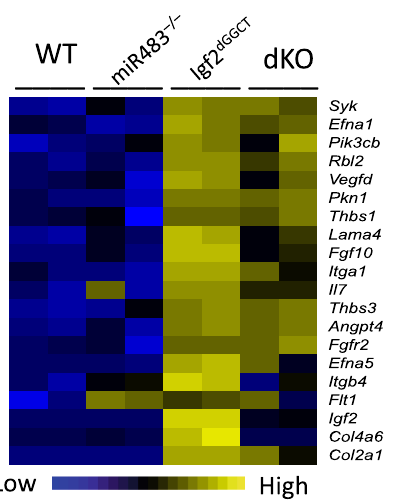
Figure 5. Comparison of RNA-seq data for wild-type, miR483 −/− , Igf2 dGGCT and dKO C2C12 cells. ( a ) Hierarchical cluster of mutant C2C12 based on RNA-seq data. ( b ) Expression of Igf2 as indicated by CPM values. ( c ) KEGG pathway analysis of DE genes in Igf2 dGGCT (left) and dKO mir483/dGGCT cells (right). ( d ) Heatmap of genes found in the PI3K-Akt signaling pathway showing differential